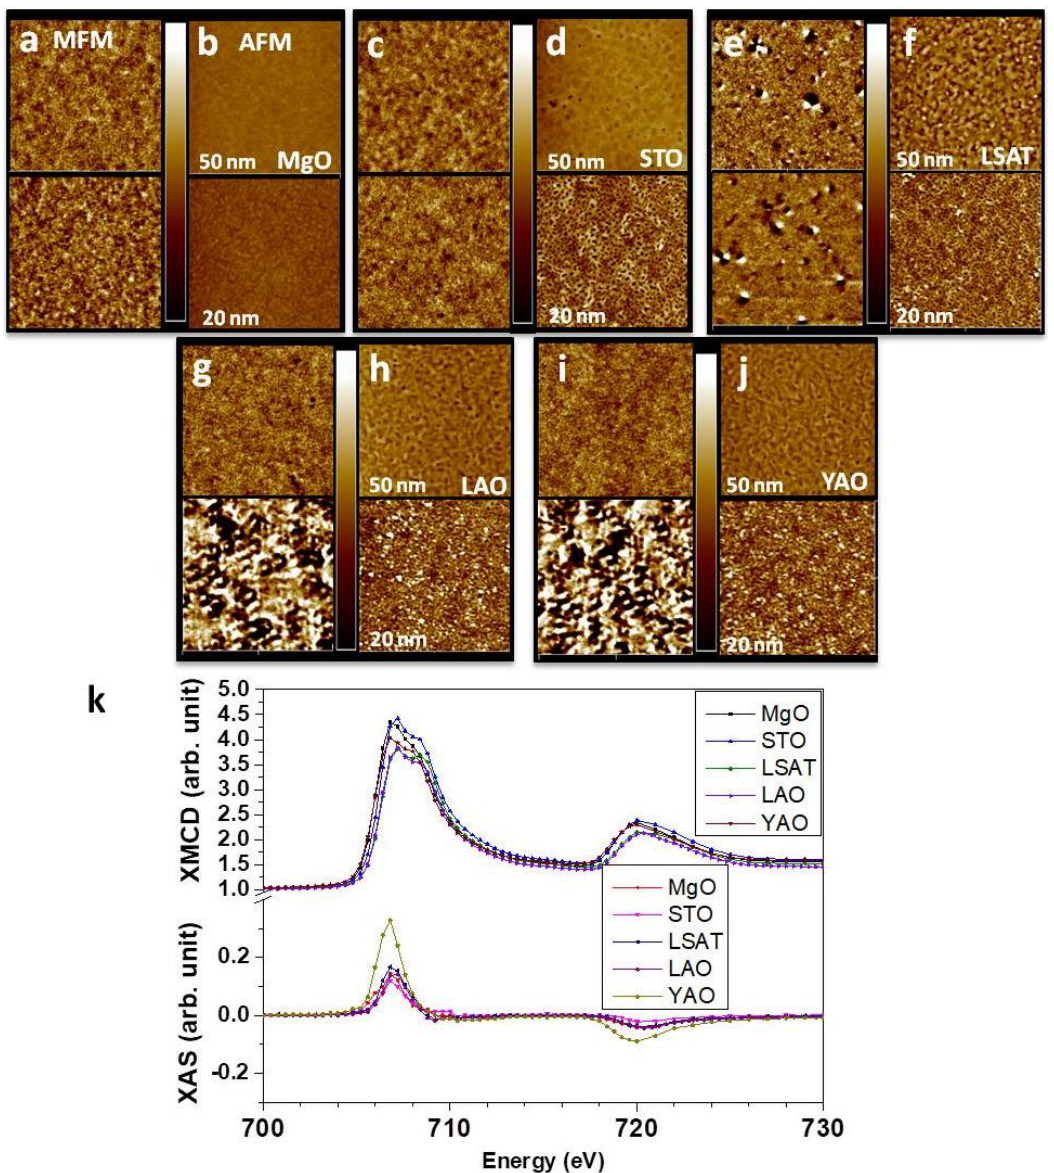
Figure 3. Magnetic properties of FeRh onto different substrates. ( a ) MFM measurements of MgO with two typical thickness, 20 nm (bottom) and 50 nm (top), respectively. ( b ) The corresponding AFM images of MFM of MgO. ( c ) MFM and ( d ) AFM of SrTiO 3 . ( e ) MFM and ( f ) AFM of La(Sr,Al)TiO 3 . ( g ) MFM and ( h ) AFM of LaAlO 3 . ( i ) MFM and ( j ) AFM of YAlO 3 substrate. Top images were measured at 50 nm and bottom images at 20 nm thickness of the substrates. The size of the images is 5 × 5 µm 2 ( k ) XMCD measurements with different substrates: MgO, SrTiO 3 , La(Sr,Al)TiO 3 , LaAlO 3 , and YAlO 3 , respectively.